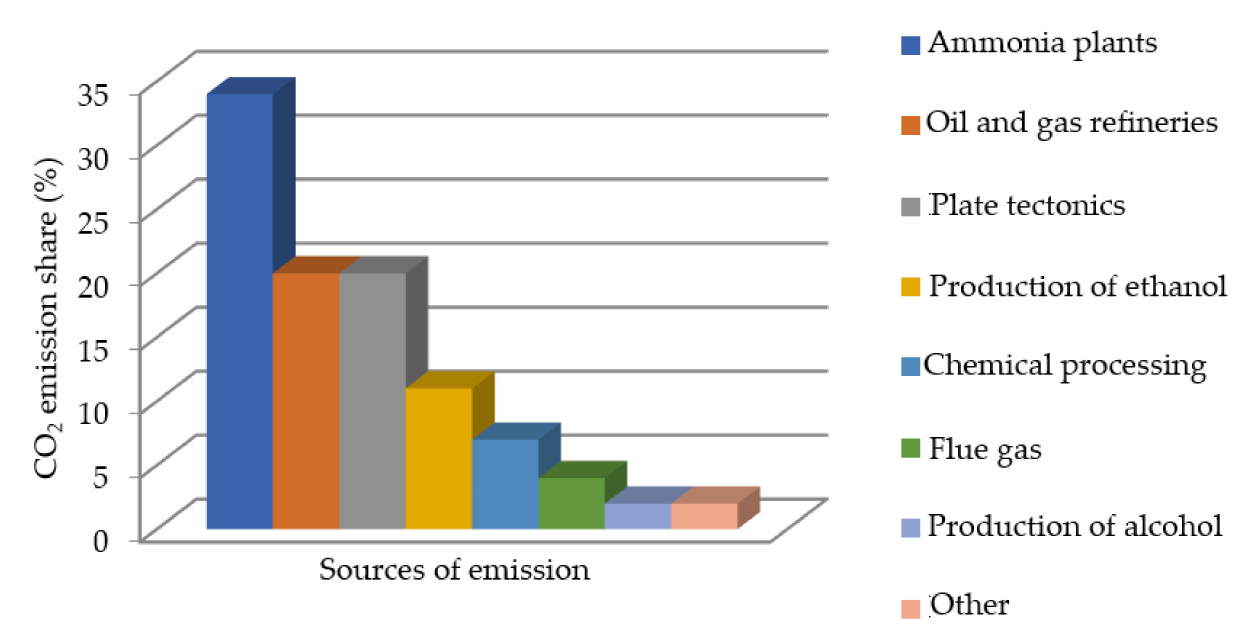
Figure 1. Main sources of carbon dioxide emissions by percentage share